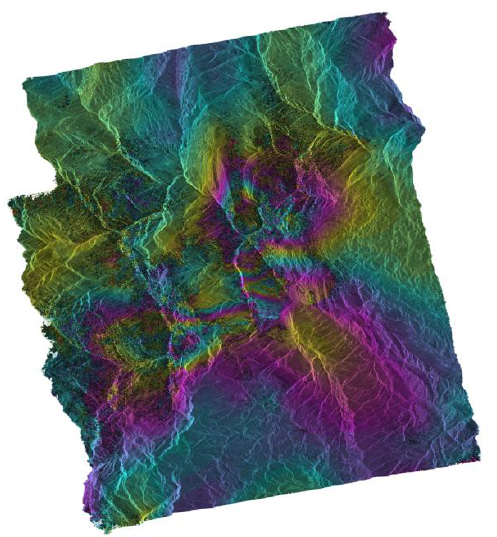
Figure 6 Interference phase diagram (after phase